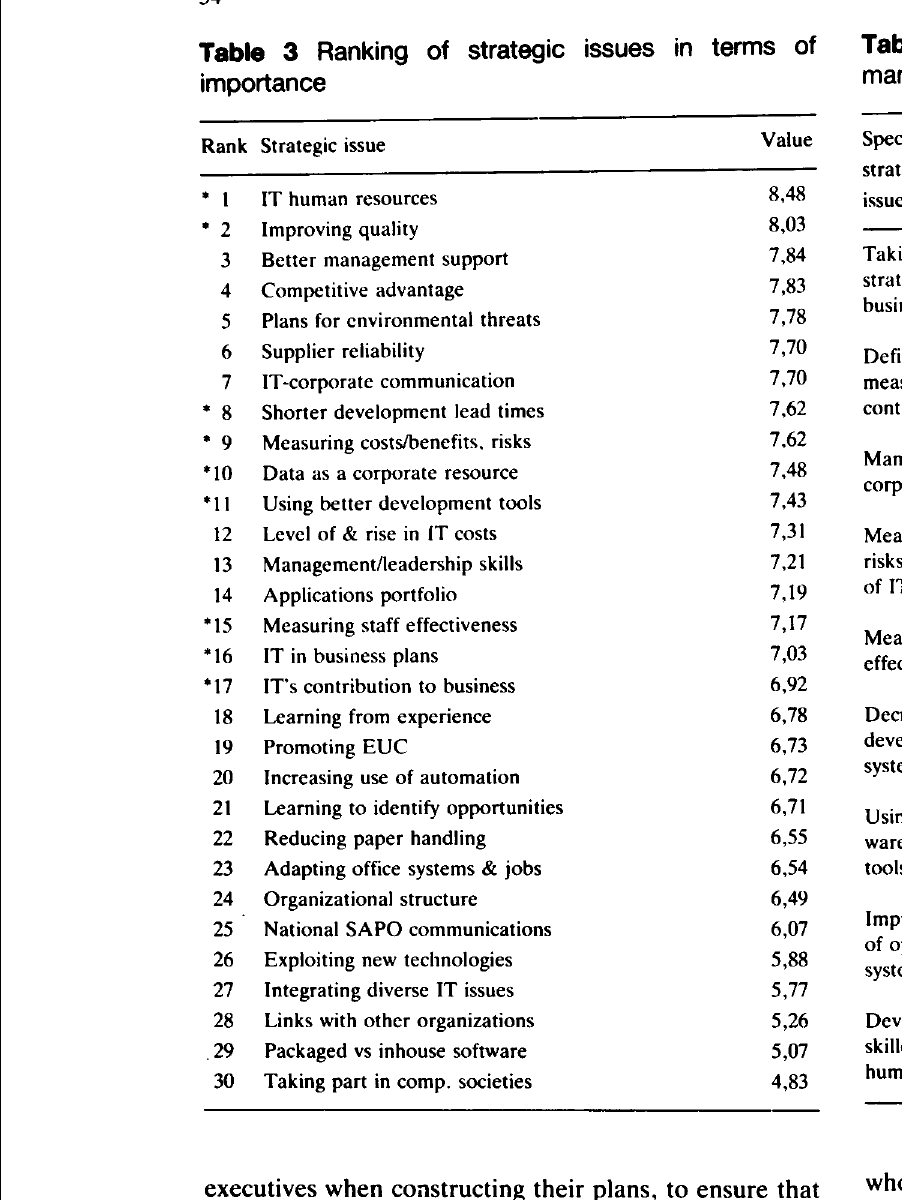
Table 3 Ranking of strategic issues in terms of importance